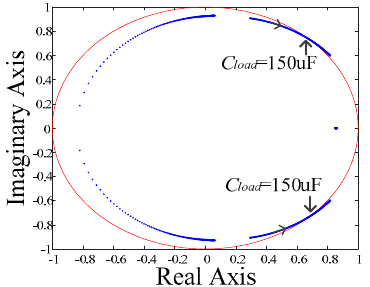
Figure 11. Poles of T(z) with change of capacitance load.